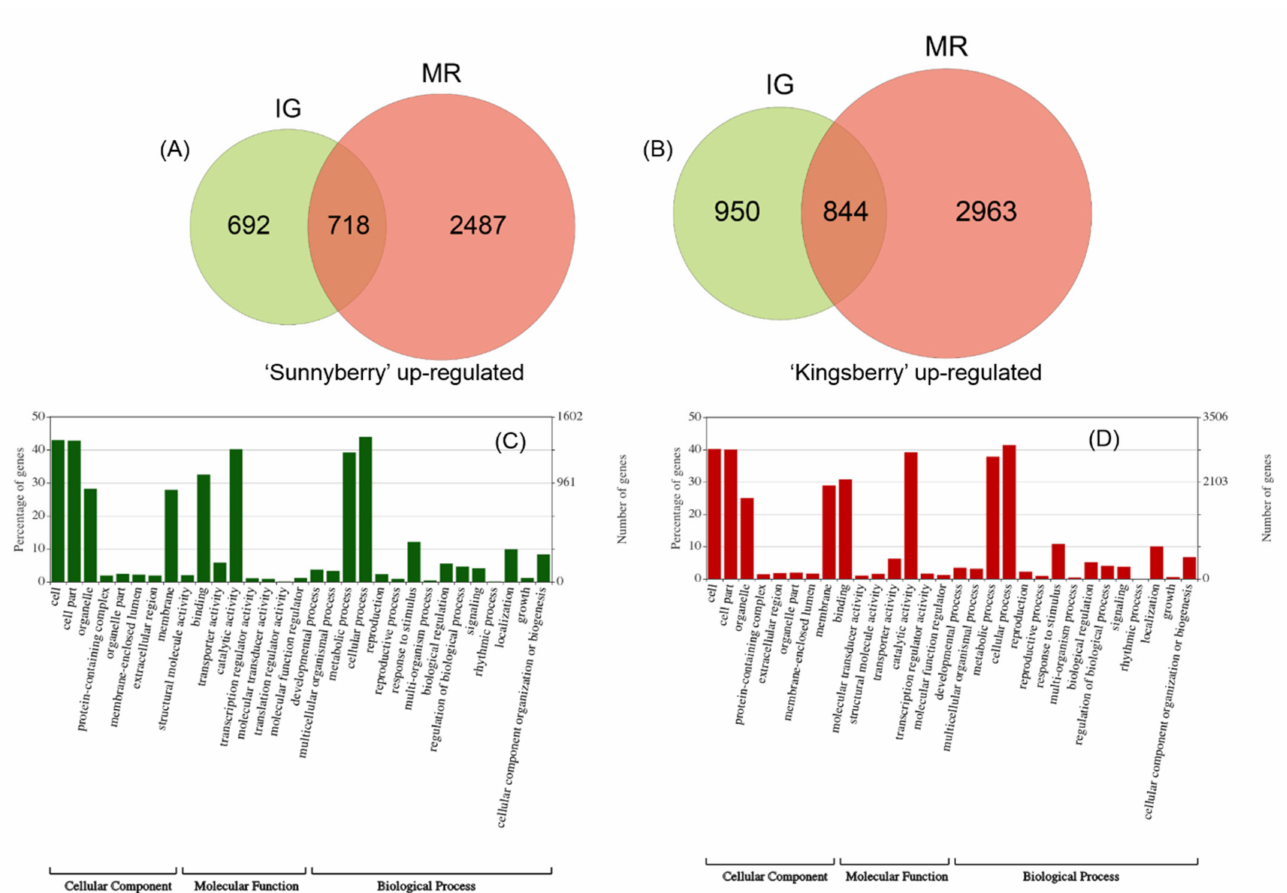
Figure 2. Transcriptomes of “Kingsberry” and “Sunnyberry” strawberry fruit. ( A ) Upregulated DEGs in “Sunnyberry” at IG and MR. ( B ) Upregulated DEGs in “Kingsberry” at IG and MR. GO annotation of DEGs at IG ( C ) and MR ( D ). DEGs were filtered using the false discovery rate (FDR) criteria p < 0.01 and |Fold change| > 2. DEGs, differentially expressed genes; GO, gene ontology; IG, immature-green; MR,